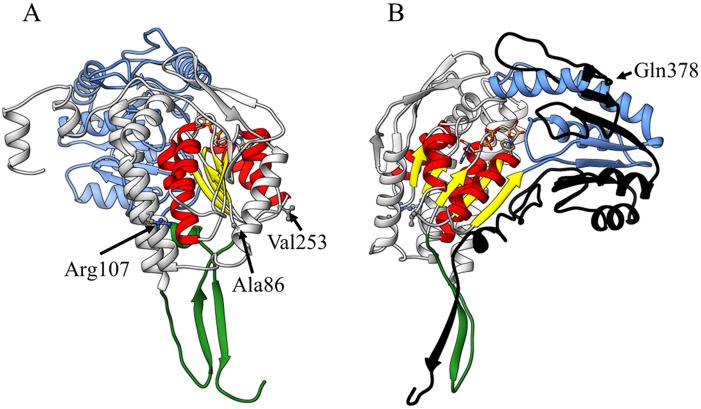
Homology model structure of the wild-type ALDH1B1 primary sequence (GI: 25777730).This model structure is annotated and rotated to illustrate the positionings of: A) the three misssense variants; and, B) the stop codon variant.